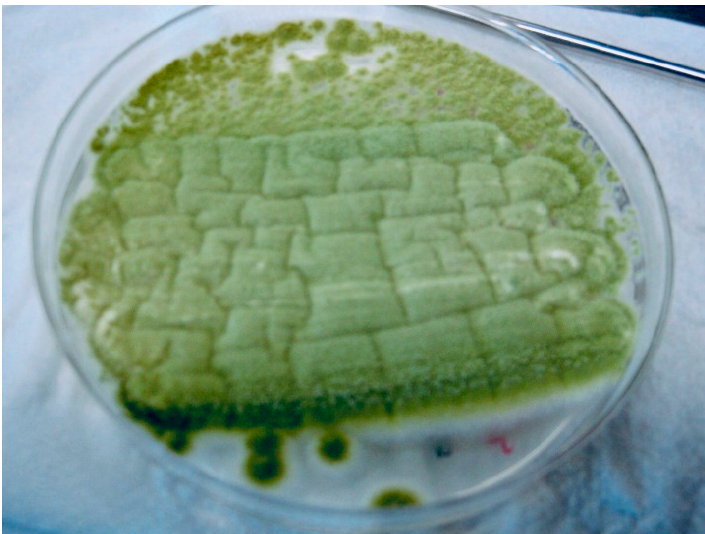
Figure 1. Culture of Aspergillus flavus on Sabouraud chloramphenicol gentamicin agar (Bio-Rad, Marnes-la-Coquette, France).